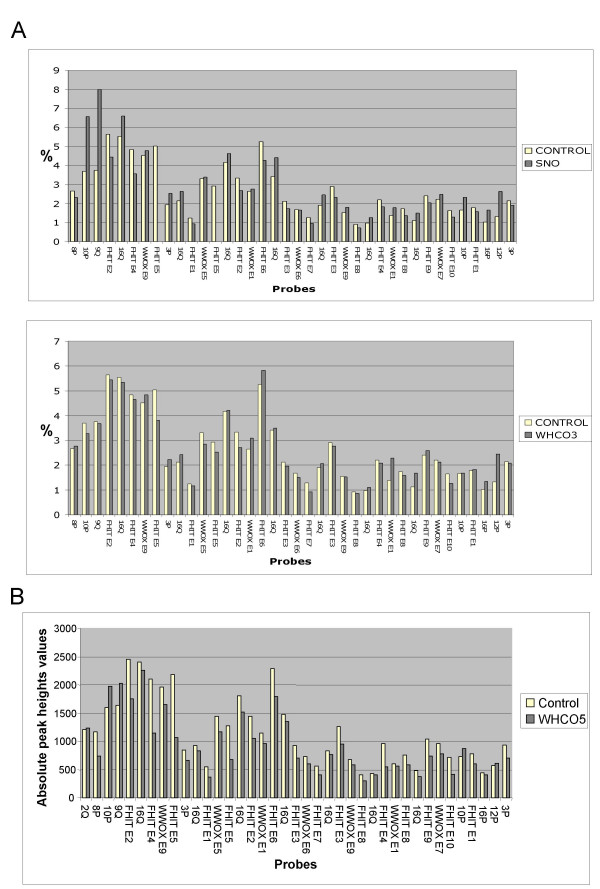
(A) Comparison of relative peak height values: control/cell lines. Comparisons of relative probe peak heights between cancer cell lines in dark grey, and control, in yellow. FHIT exon specific probes are marked FHIT E1, E2...and WWOX exon probes: WWOX E1, E2. Internal controls probes are labeled according to their chromosomal location. Top, cell line SNO showing a homozygous deletion of FHIT exon 5 with both exon 5 probes. The second and third internal control probes, on 10p and 9q, appeared increased in copy number in SNO. They were not used to normalize data when ratios were derived from absolute peak height values. Middle, no significant deletion nor amplification in either FHIT or WWOX was seen in WHCO3. (B) Absolute peak height values, comparison control/cell line WHCO5. Bottom, comparison of absolute probe peak heights between WHCO5 in dark grey, and control, in yellow. FHIT exons 4 and 5 were present in half copy number. Controls probes on chromosome 16 were consistent with the external control.